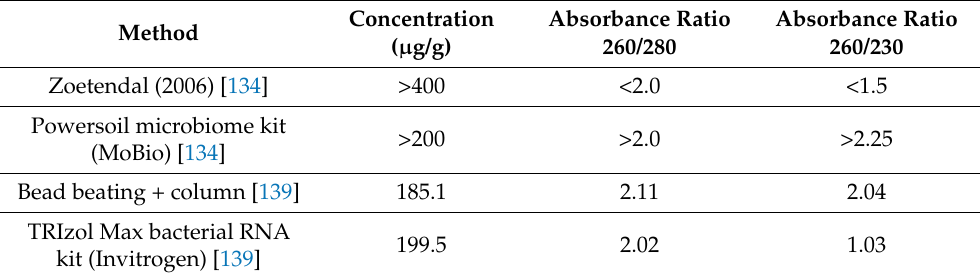
Table 2. Comparative studies are displaying RNA quality and